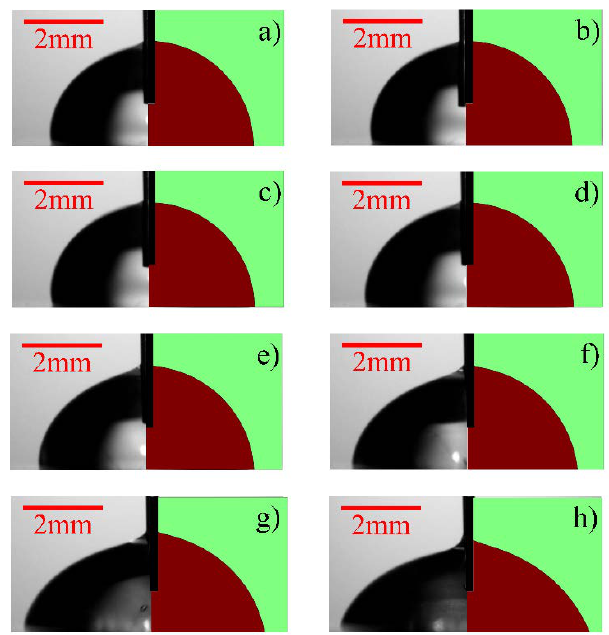
Figure 4. Voltage measurements (solid blue line) during electrowetting and a curve (dotted black line) that fits the experimental data.